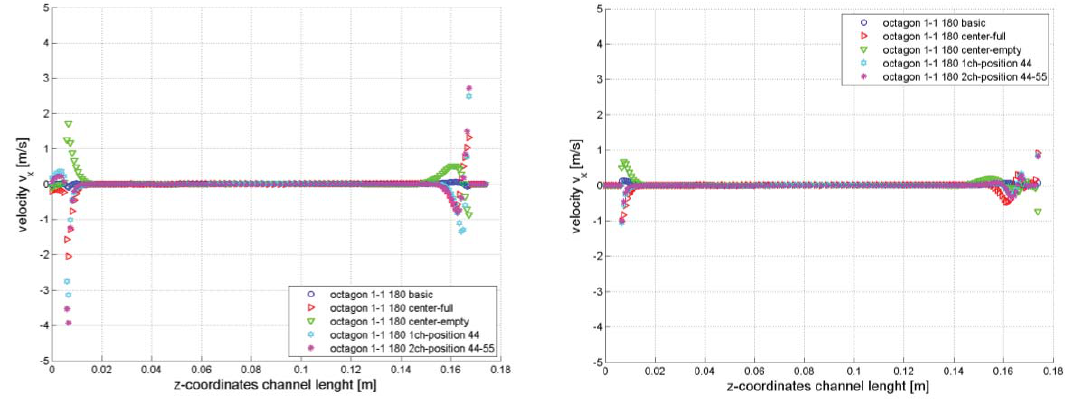
Figure 8: Development of velocity v X in an open and closed